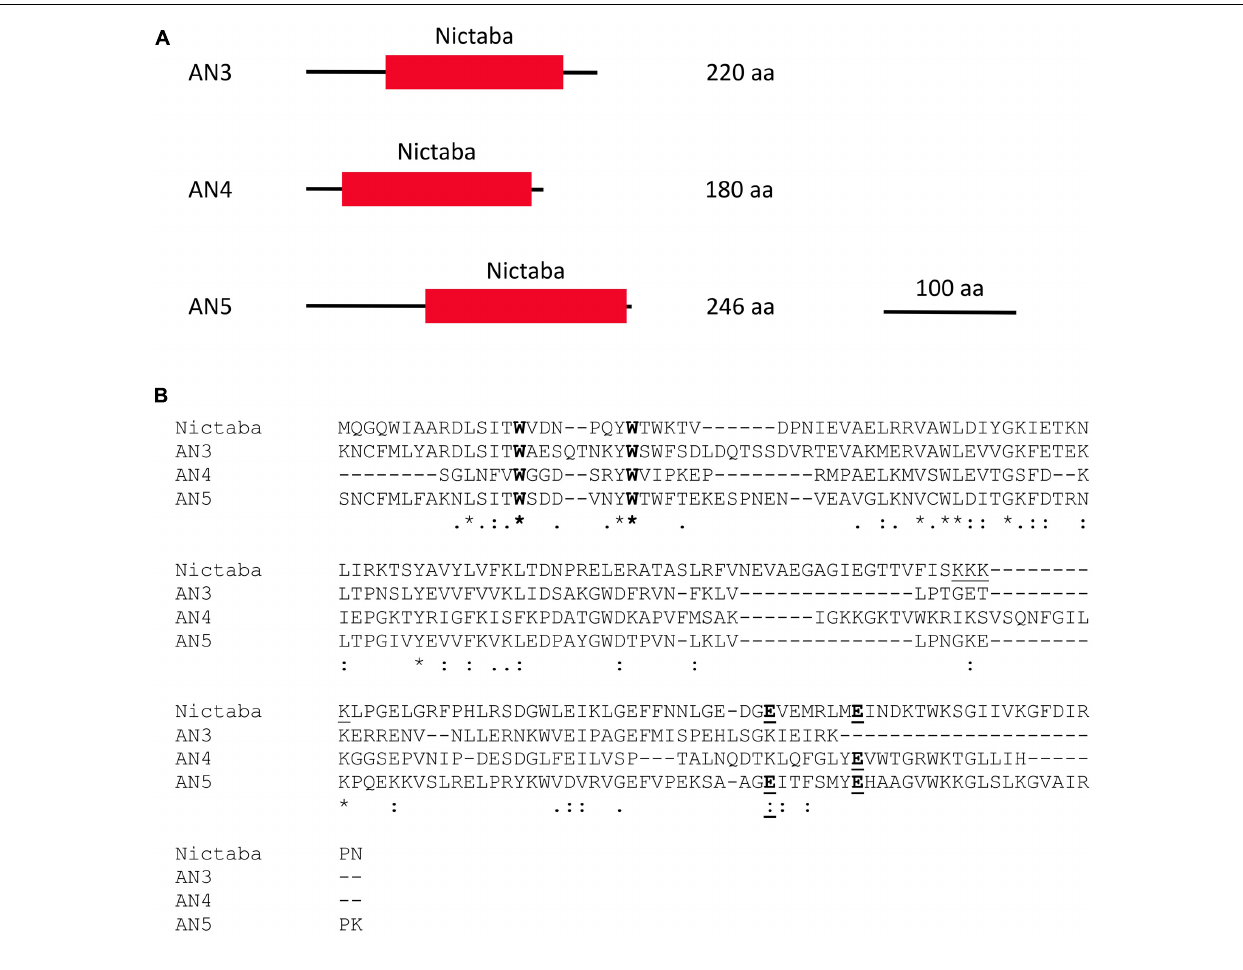
FIGURE 1 | Domain architectures of AN3, AN4, and AN5 (A) , and protein sequence alignment of the Nictaba sequence and the Nictaba domains of the ArathNictabas (B) . (A) The domain architectures are drawn to scale. The scale bar represents 100 AA. (B) The tryptophan residues important for carbohydrate binding in Nictaba are marked in bold (Trp15, Trp22). The glutamic acid residues (Glu138 and Glu145) are marked in bold and underlined. The NLS of Nictaba is underlined.